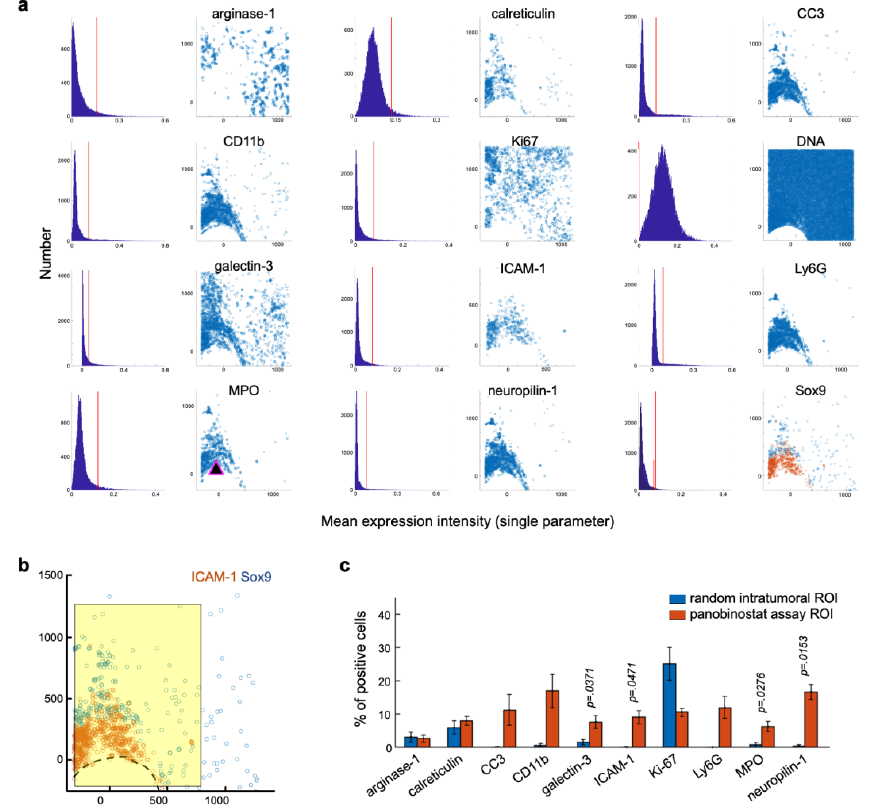
Figure 2. Panobinostat induces treatment-specific infiltration of myeloid cells and enrichment of candidate ICB biomarkers. ( a ) Marker expression in XY coordinates in the panobinostat assay area. Each dot represents a marker-positive cell, as titled above the scatter plot. The single-parameter threshold for positivity was defined by manual gating using FCS Express 6 and 7 Image Cytometry Software, visual inspection, and positive control tissue. The mean expression intensity is presented in the form of a histogram, and the threshold for positivity is depicted by a red line (left graphs). ( b ) Magnified view of ICAM-1 and Sox9 expression in XY space. Coordinate [0,0] identifies the drug source, and the direction of the drug release is upward. Graphs are shown offset to the left so that both the panobinostat assay region (yellow) and the non-affected control area are visible in the presented space. ( c ) Quantification of single-cell events inside the panobinostat assay area compared to control. Bars are means ± s.e.; n = 3 reservoirs from two to three MMTV-PyMT tumors. The device was implanted for three days. Significance was calculated using a paired-sample two-tailed t- test.